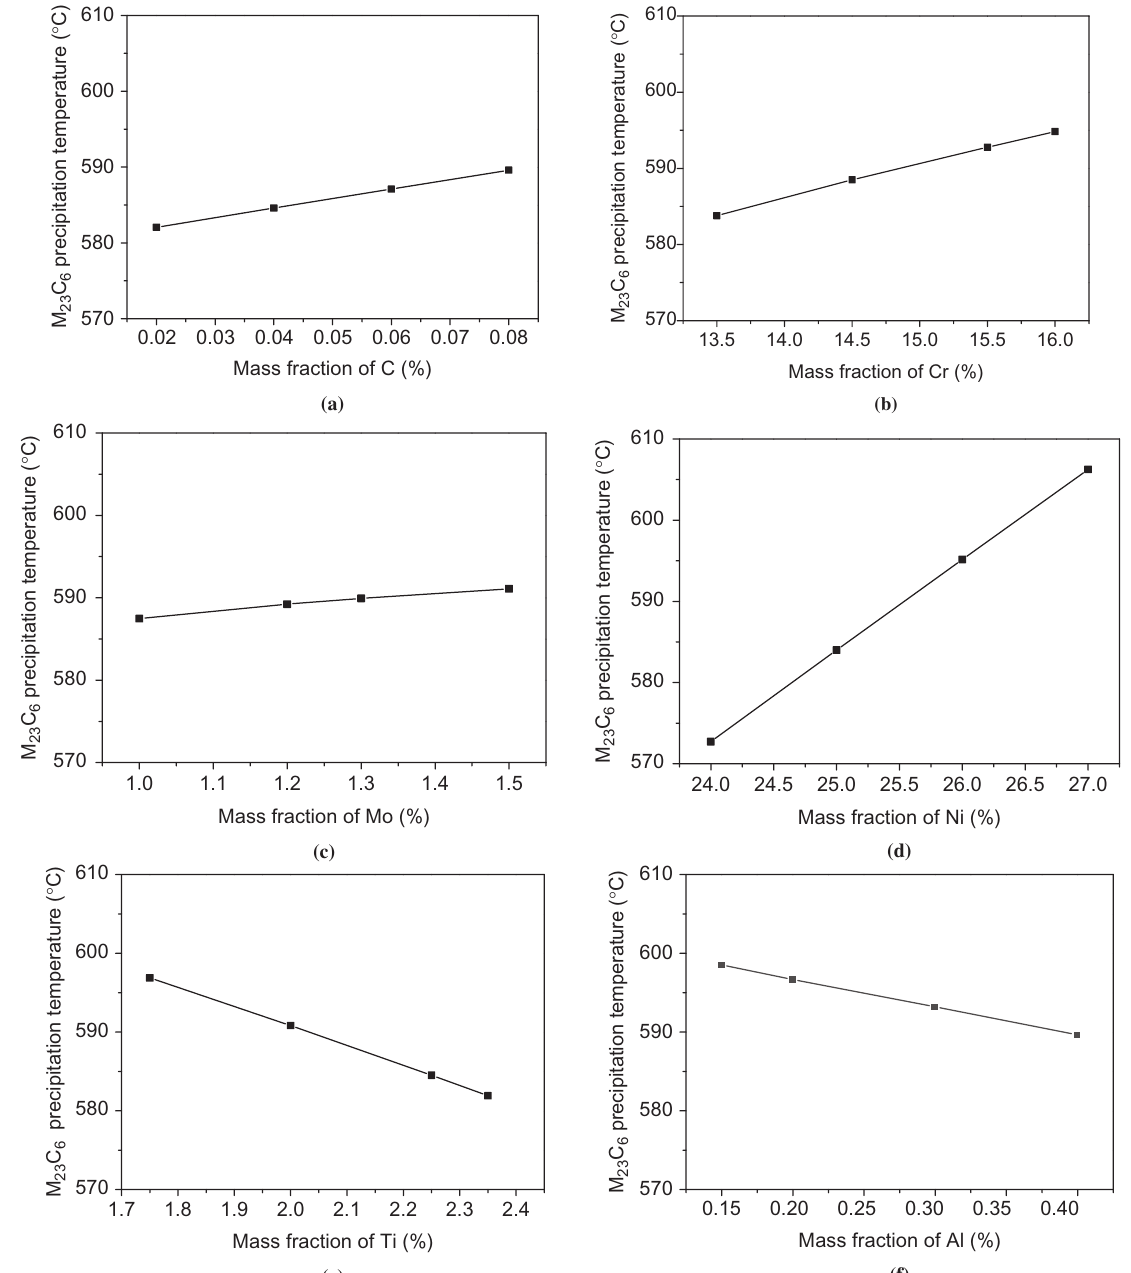
Figure 7: Variation of precipitation temperature of M 23 C 6 phase with the contents of (a) C; (b) Cr; (c) Mo; (d) Ni; (e) Ti; (f)